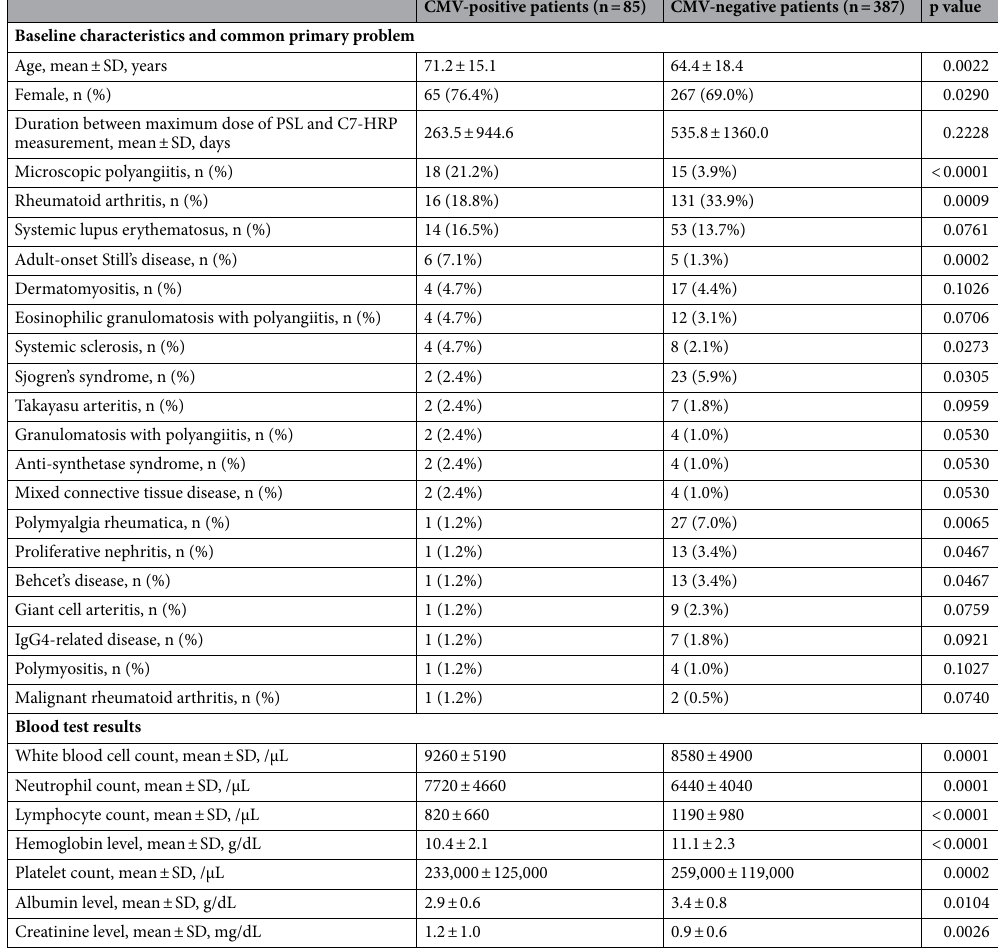
Table 1. Baseline characteristics, common primary problem, and blood test